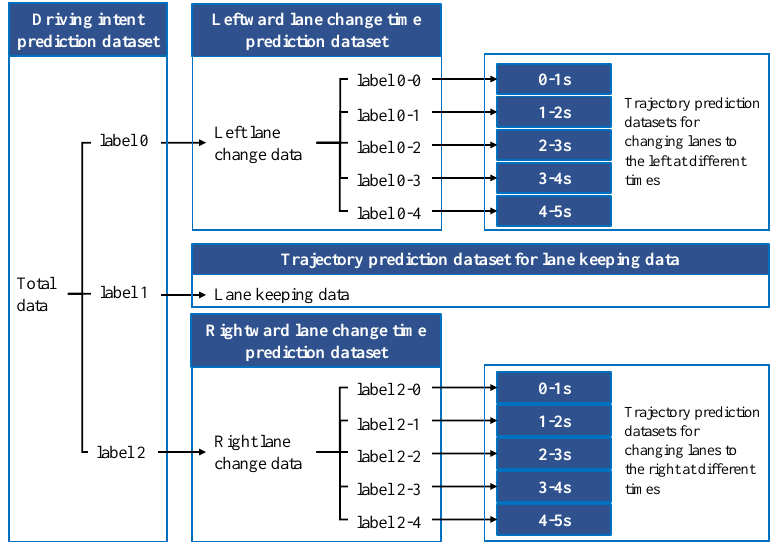
Figure 2. Dataset segmentation